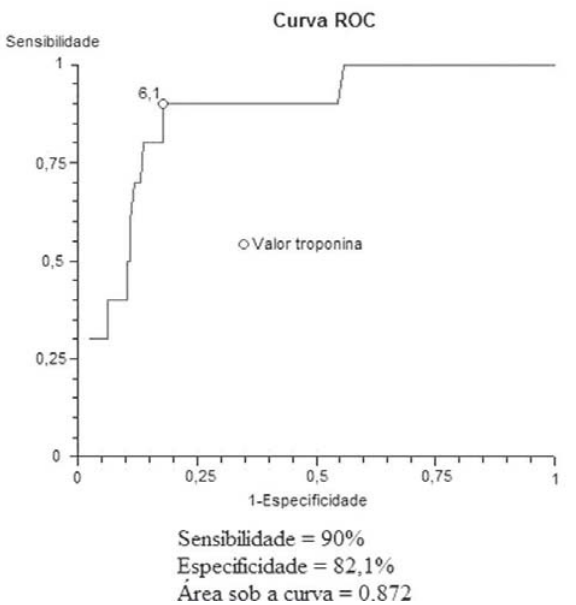
Fig. 1 - Curva ROC mostrando ponto de máxima sensibilidade e dia pós-operatório e ocorrência de infarto agudo do miocárdio